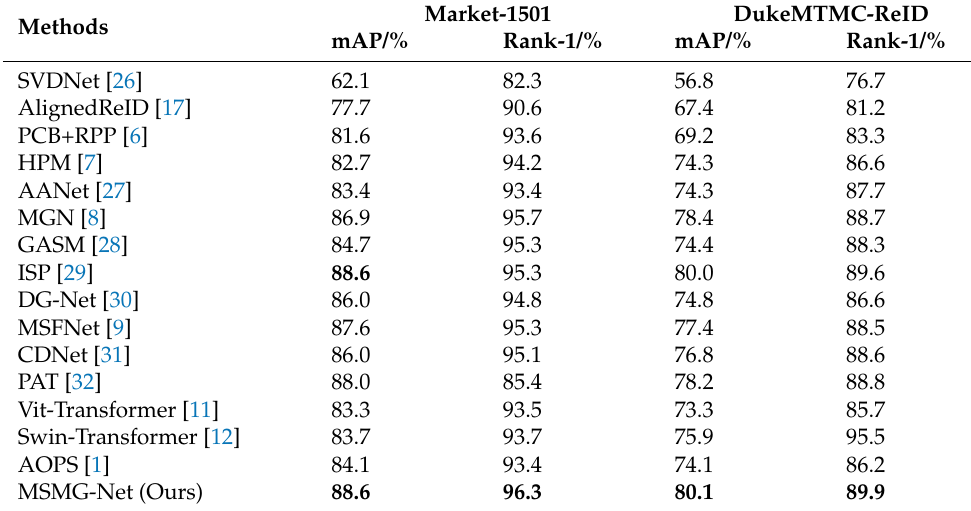
Table 1. Comparison of the experimental results between MSMG-Net and other mainstream